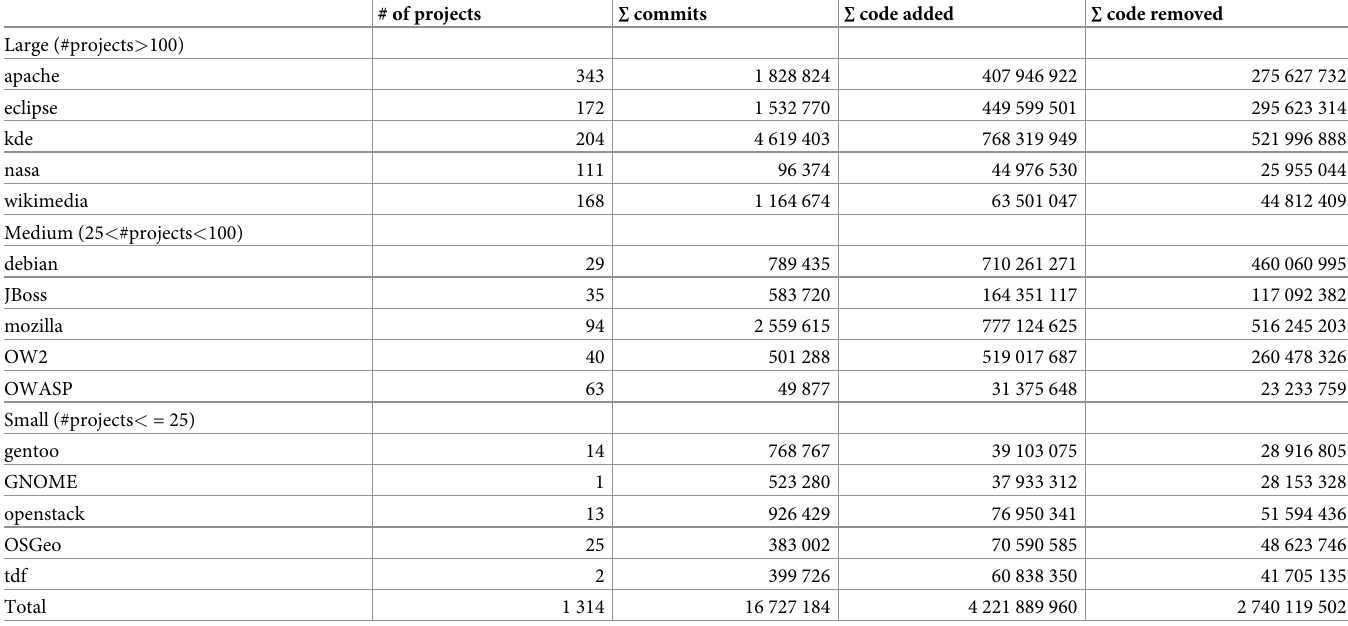
Table 4. Projects, commits and code size